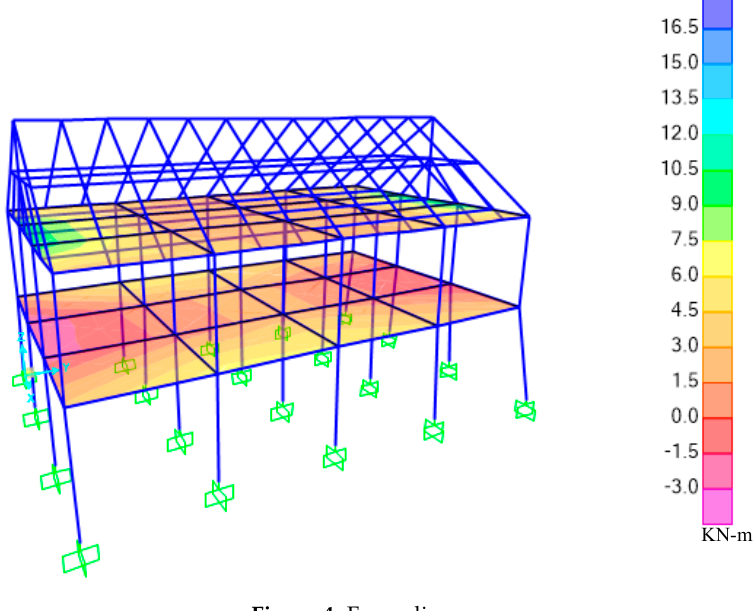
Figure 4. Fmax Figure 4. Fmax diagram.